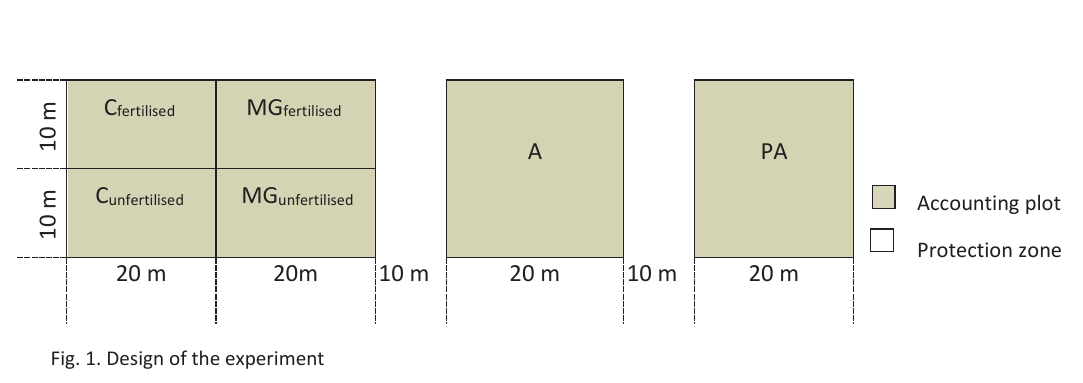
Fig. 1. Design of the